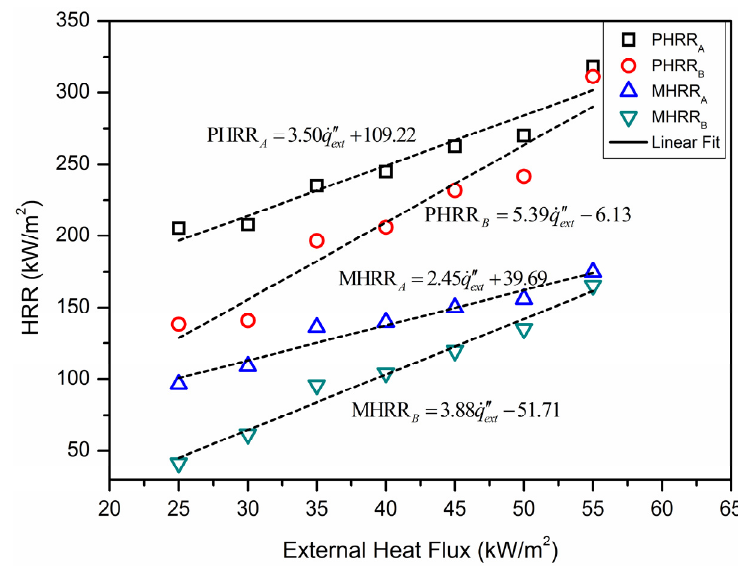
Figure 5. The peak and mean values of HRR for different heat fluxes.